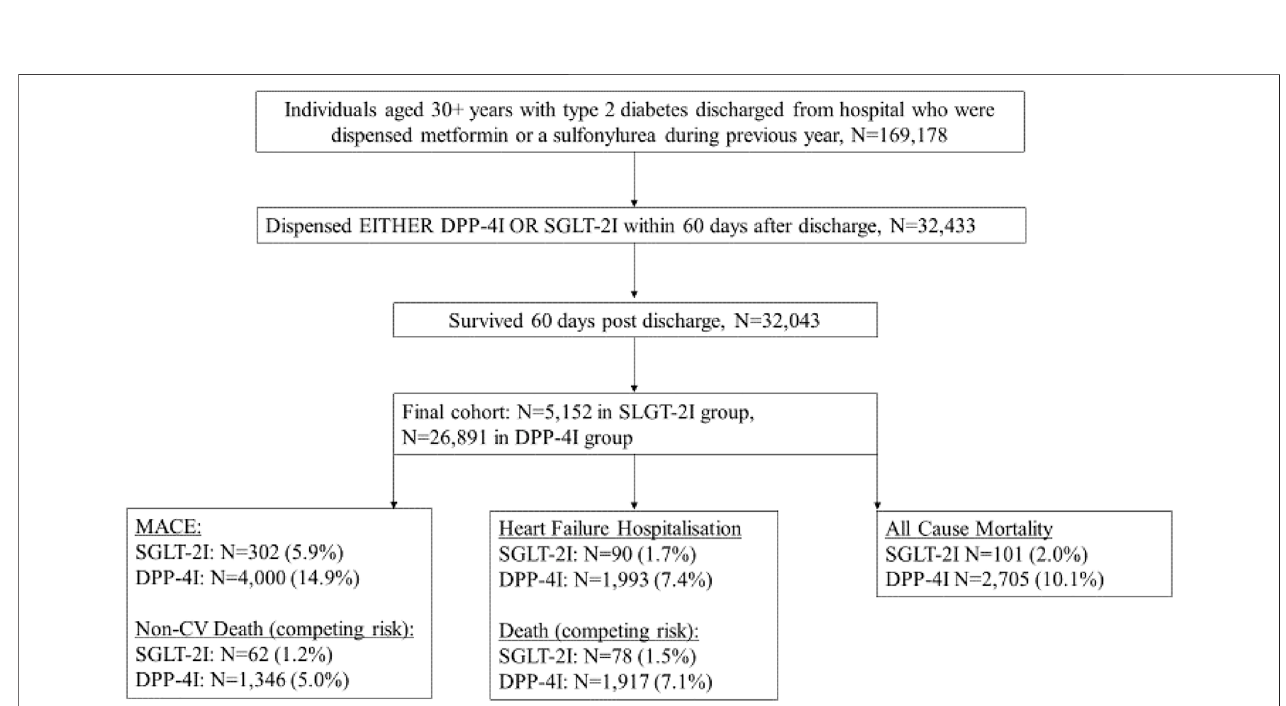
FIGURE 2 | A fl owchart indicating how cohort was obtained and numbers of outcomes.